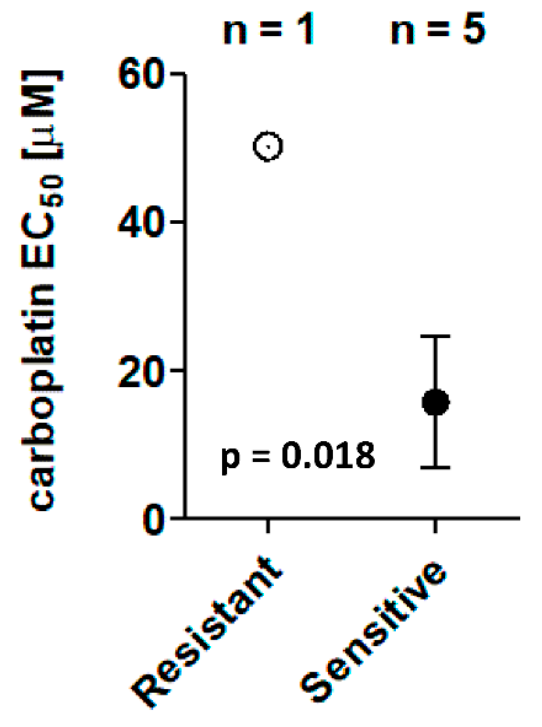
Figure 2. Scatter plot demonstrating cell viability EC 50 mean ± SEM for the carboplatin-resistant (UK1254) and pooled carboplatin-sensitive TO lines when treated with carboplatin. One sample t -test was used to compare resistant and sensitive EC 50 values ( p = 0.018).